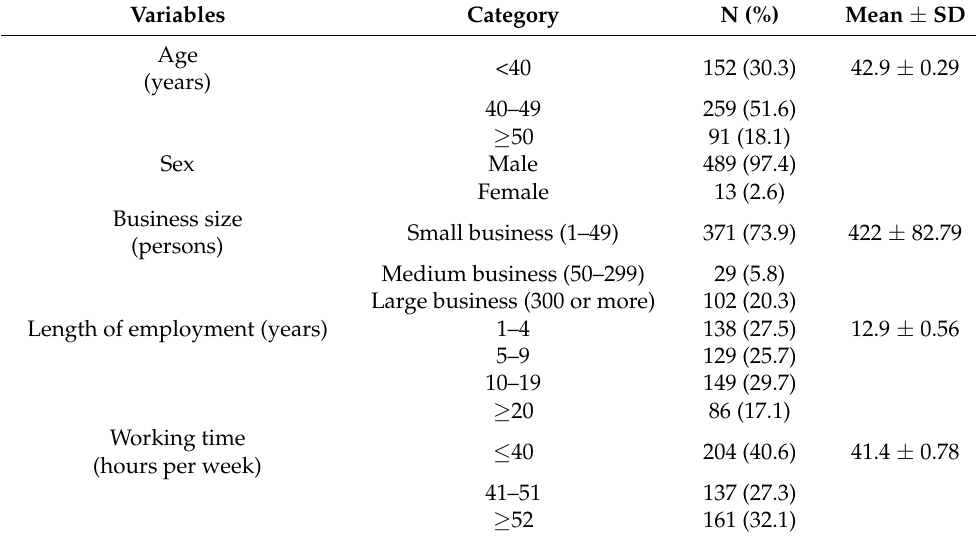
Table 1. General characteristics of the subjects ( n = 502).